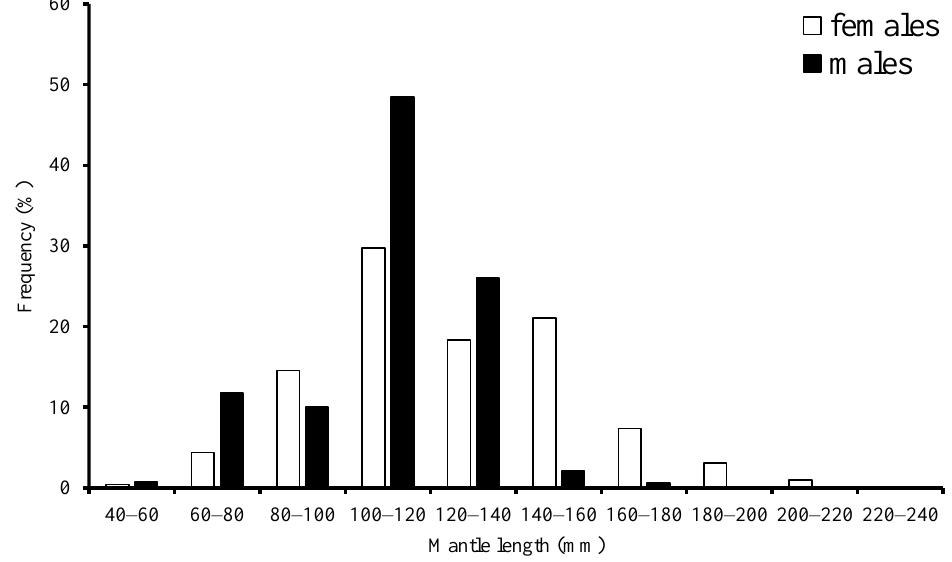
Figure 2. Frequency distribution of mantle length for S. oualaniensis in the waters of the Xisha Islands of the South China Sea.